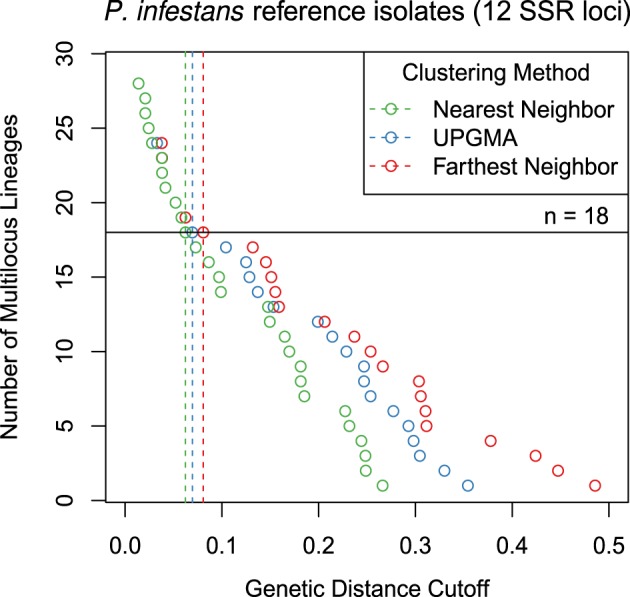
Graphical representation of three different clustering algorithms collapsing multilocus genotypes for 12 SSR loci from
Phytophthora infestans
representing 18 clonal lineages. The horizontal axis is Bruvo's genetic distance assuming the genome addition model. The vertical axis represents the number of multilocus lineages observed. Each point shows the threshold at which one would observe a given number of multilocus genotypes. The horizontal black line represents 18 multilocus genotypes and vertical dashed lines mark the thresholds used to collapse the multilocus genotypes into 18 multilocus lineages.